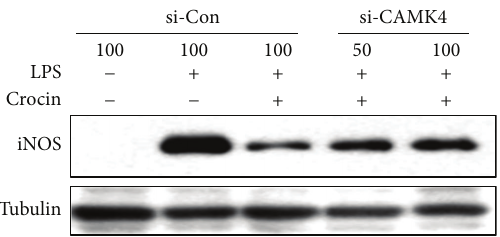
Figure 9: CAMK4 is necessary for crocin-mediated inhibition of iNOS expression in LPS-stimulated macrophages. RAW 264.7 cells were transfected with CAMK4 siRNA or control siRNA and then treated with crocin (500 𝜇 M). After 3h, cells were incubated with LPS (0.1 𝜇 g/mL) for 24 h. Equal amounts of cytosolic extract were analyzed by Western blotting. Tubulin was used as a loading